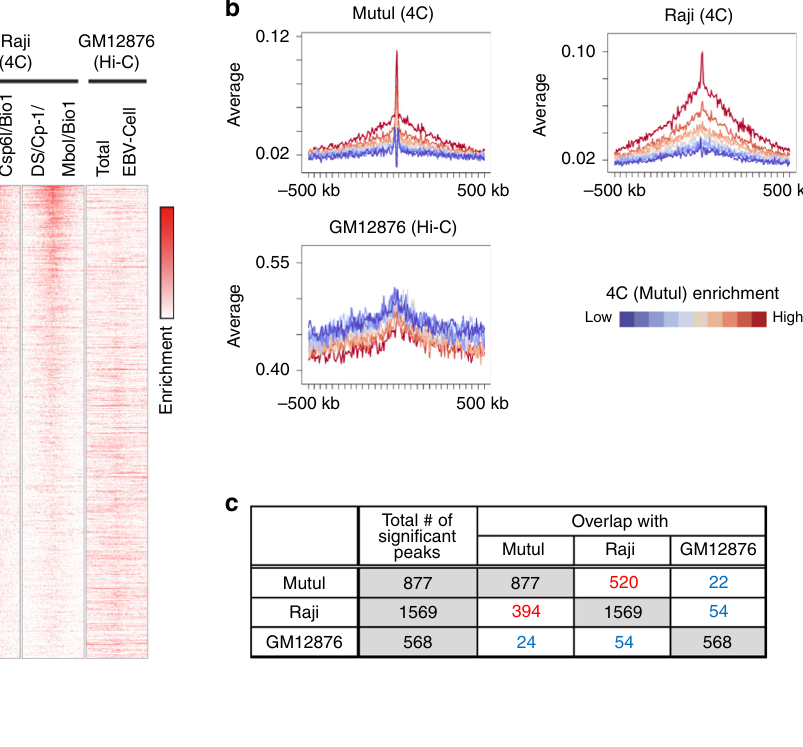
of a speci fi c high-frequency 4C peak at chr2:15.6 Mb (Supple- mentary Fig. 8e, f). RNA analysis of several 4C associated genes revealed a signi fi cant upregulation after EBNA1 depletion (Fig. 6b, c). To determine if this trend held genome-wide, we analyzed the average expression of Top10% 4C target genes compared to other genes. This analysis revealed an average ( p < 0.01) lower expression level for Top10% 4C target genes com- pared to non-4C target genes in MutuI and Raji cells (Fig. 6d, e). This trend was further corroborated by comparing the average expression of 4C target genes to non-4C target genes (Fig. 6f). 4C